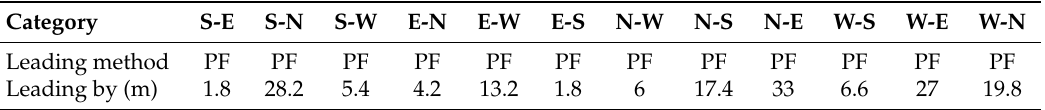
Table 3. Method and distance, leading (i.e., succeeding earlier in) intention estimation in terms of the grid-cell location closest to the mean decision point for each test category. PF represents particle-filter based method, and S–E represent